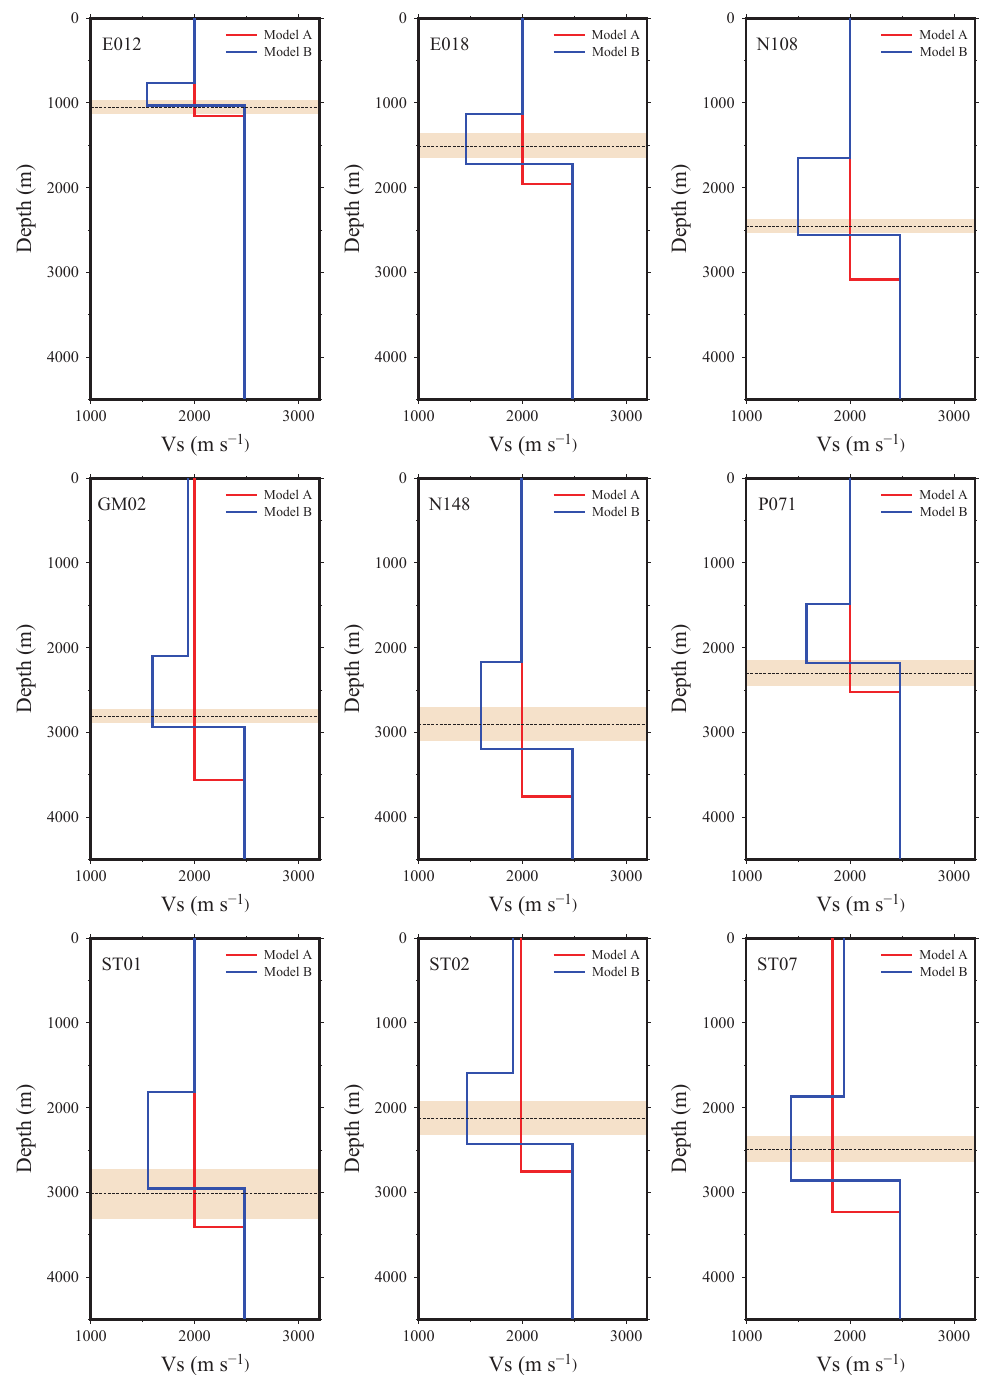
Figure 5. The optimum inversion shear-wave velocity models for the nine stations. The horizontal dashed line in each plot indicates the reference Bedmap2 ice thickness, and the shaded area shows the uncertainty of the Bedmap2 ice thickness. As can be seen, the inversion ice thickness results derived from the two-layer structure (model B) are much closer to the Bedmap2 thickness than those determined using the single ice layer (model